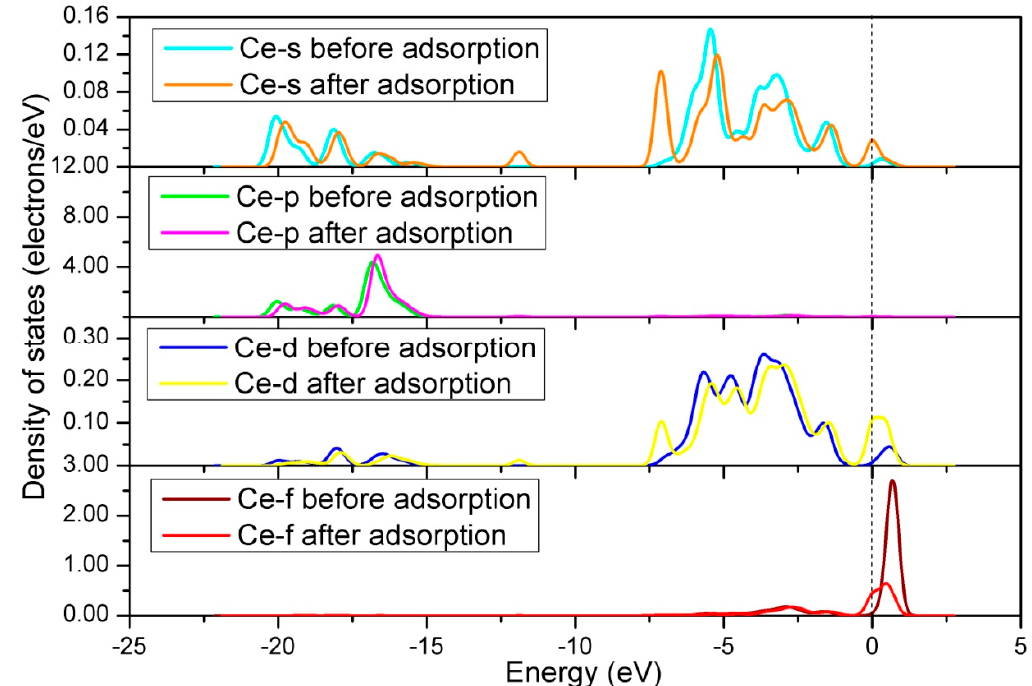
Figure 10. Density of states of Ce atom before and after NO adsorption for the Ce-doped LaO-terminated LaCoO 3 (011) surface.